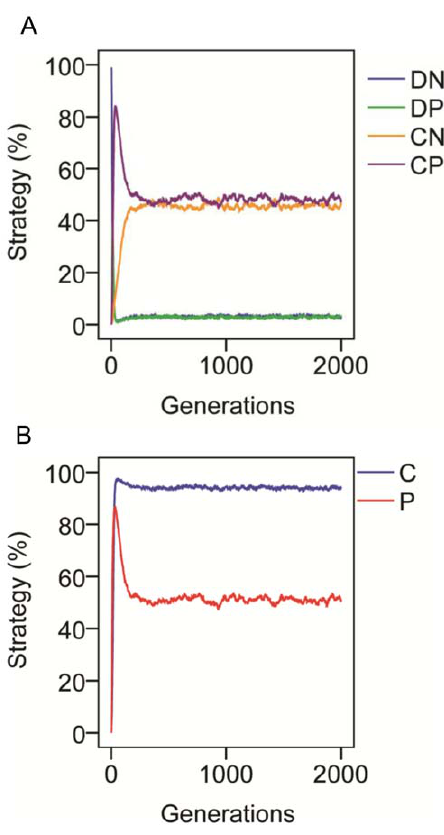
Figure 1. The evolutionary dynamics of cooperation and punishment. Representative example of strategy dynamics from the first of 10 simulations with parameters g =3, k =2, p =1, q =3, showing (a) frequencies of all strategy combinations (C=cooperator, D=re- sponsive defector; P=punisher, N=non-punisher) and (b) summed frequencies of cooperative and punishing strategies.